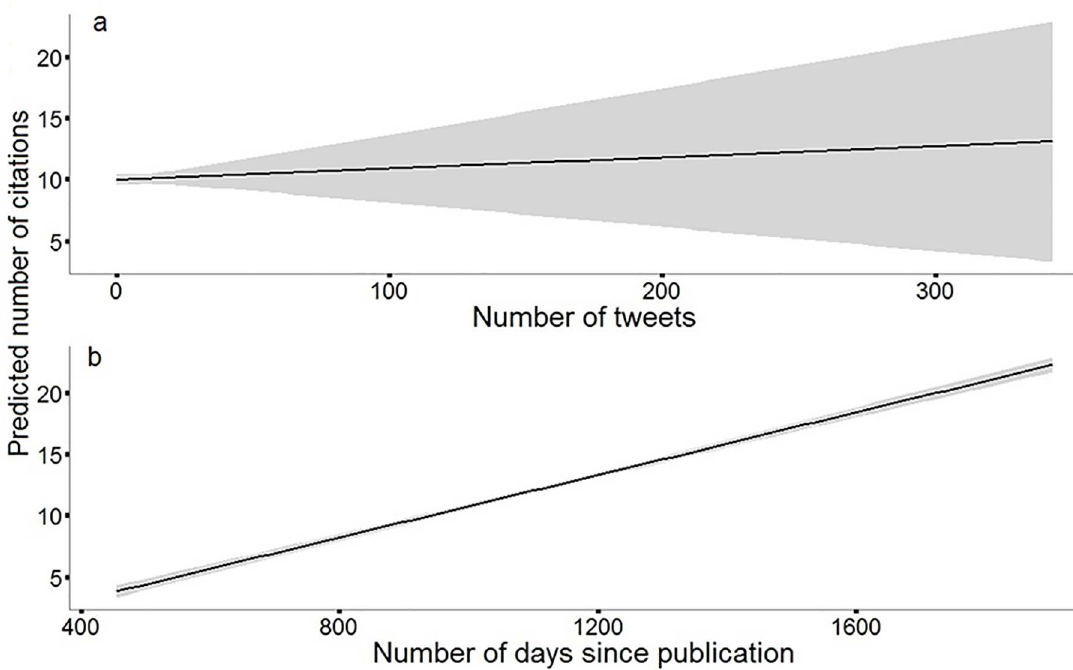
Fig 2. Model-predicted number of Web of Science citations an article receivedas a function of (a) the number of tweets about that article and (b) time since the article was published. The solid black line represents a fitted line from predicted values bounded by standarderror